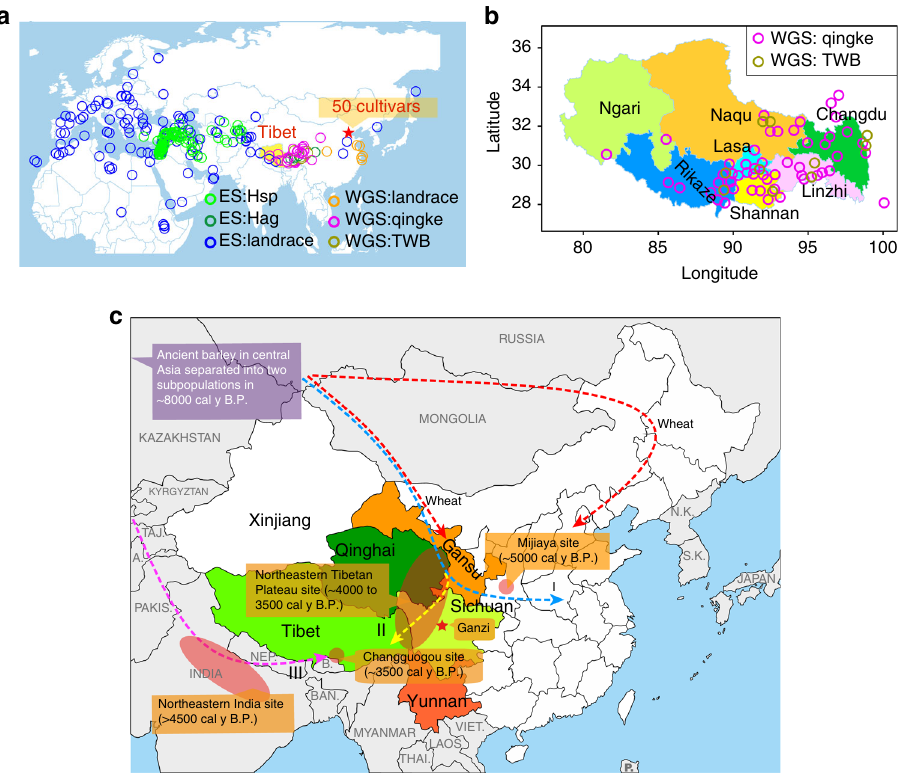
Fig. 1 Geographical distribution and possible introduction routes. a Global distribution of the barley accessions. WGS whole genome sequencing accessions, ES exome sequencing accessions, Hsp H. spontaneum, Hag H. agriocrithon , TWB Tibetan weedy barley. The pentagram indicates the location of National Crop Genebank of China (NCGC), which provided 50 WGS barley cultivar accessions. b Distribution of qingke landrace and Tibetan weedy barleys in seven areas of Tibet. The seven areas are identi fi ed by different colors. c Possible introduction routes of qingke from Central Asia to Tibet. The nearby provinces (Qinghai, Gansu, Sichuan and Yunnan) of Tibet where Tibetans (Zang people) live are identi fi ed by different colors. The circle or ellipse indicates the location of the barley archaeological site, including Mijiaya 18 , northeastern Tibetan Plateau 19 , northeastern India 21 , and Changguogou 22 . The pentagram indicates the location of Ganzi, where ÅEberg discovered and described H. agriocrithon in 1938 for the fi rst time 8 . The red dash line indicates the reported introduction route of wheat 13 – 17 . The blue dash line (route I) indicates the introduction route of barley in North and Eastern China 13 – 19 . The yellow dash line (route II) indicates the possible introduction route for qingke from Northern Tibet 19 . The magenta dash line (route III) indicates the new discovered route for introduction of qingke from south Asian reported in this study. a , b were generated in R (V3.4.3) using packages maps, maptools, plyr, ggrepel, and ggplot2. Geographic information data were obtained from Global Administrative Areas database (GADM V2.8, November 2015). The original map of c was from https://d-maps.com/carte.php?num_car = 11572&lang = en. Source data are provided as a Source Data fi